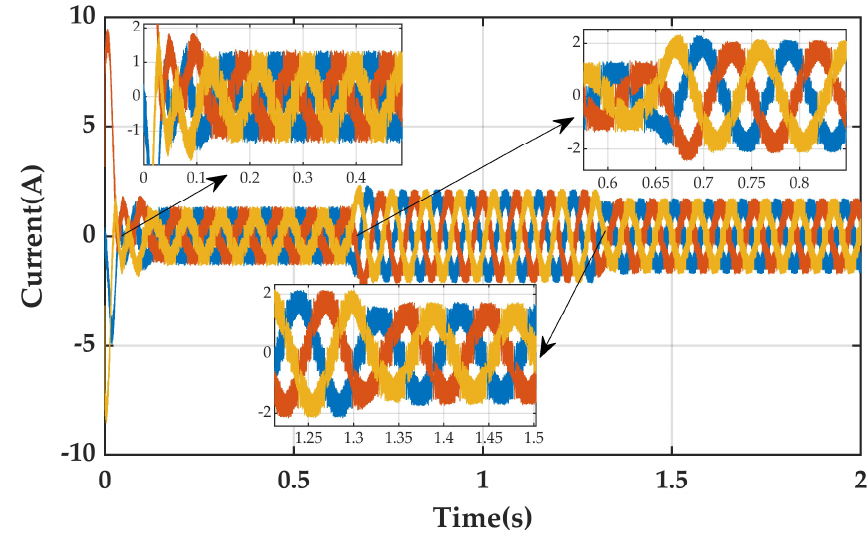
Figure 10. Three-phase current change curve of the PI controller.